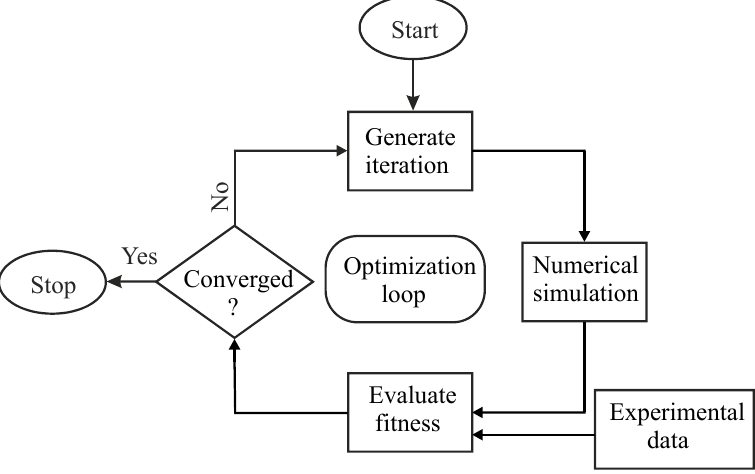
Figure 7. Optimisation loop used to optimise material parameters for J2 plasticity and CP.